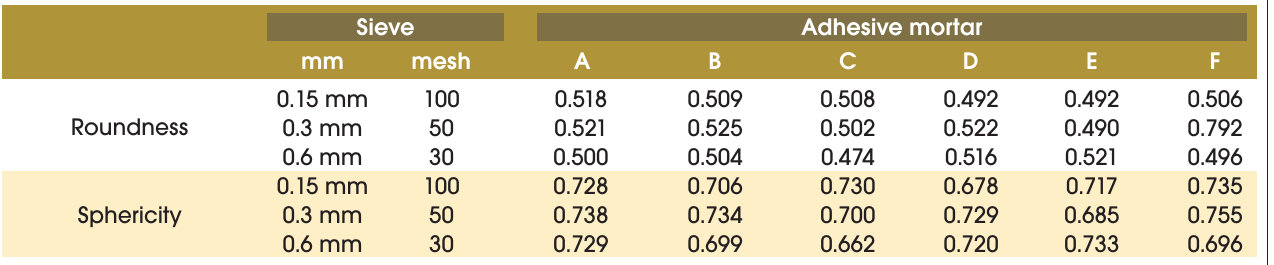
Table 5 – Specific gravity and the air entrained content in the adhesive mortar